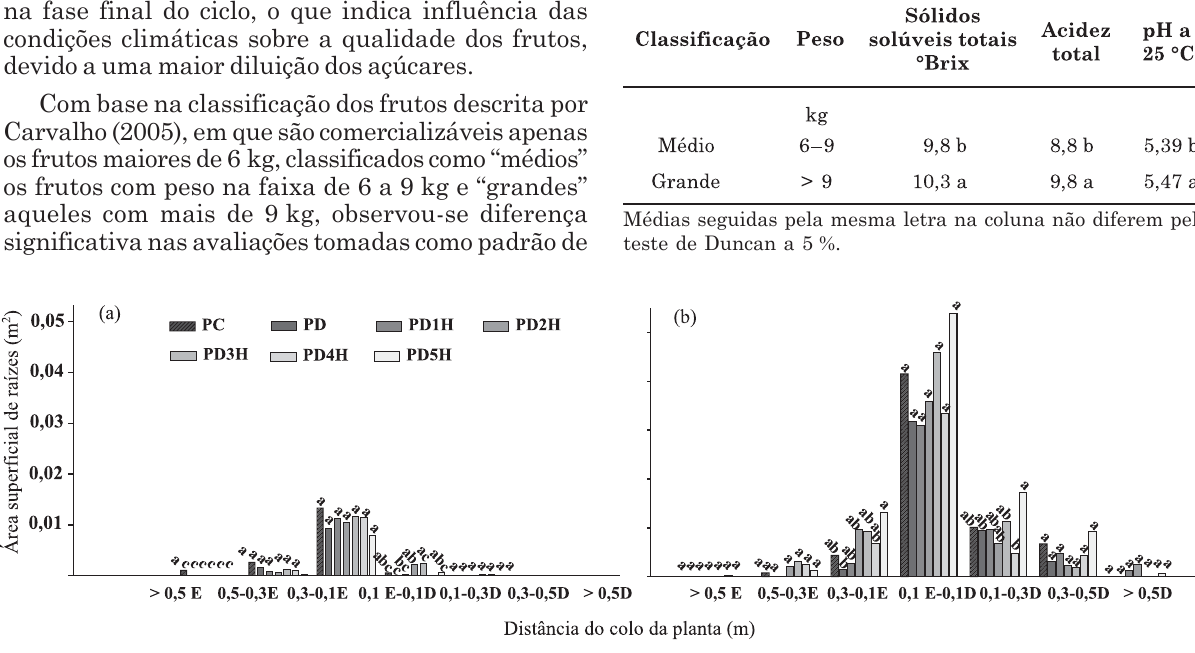
Figura 3. Distribuição longitudinal do sistema radicular da melancia 30 d após a semeadura (a) e 60 d após a semeadura (b). (PC: preparo convencional; PD: plantio direto; PD1H: PD escarificado com uma haste de escarificador; PD2H: PD escarificado com duas hastes; PD3H: PD escarificado com três hastes; PD4H: PD escarificado com quatro hastes; PD5H: PD escarificado com cinco hastes). Barras com